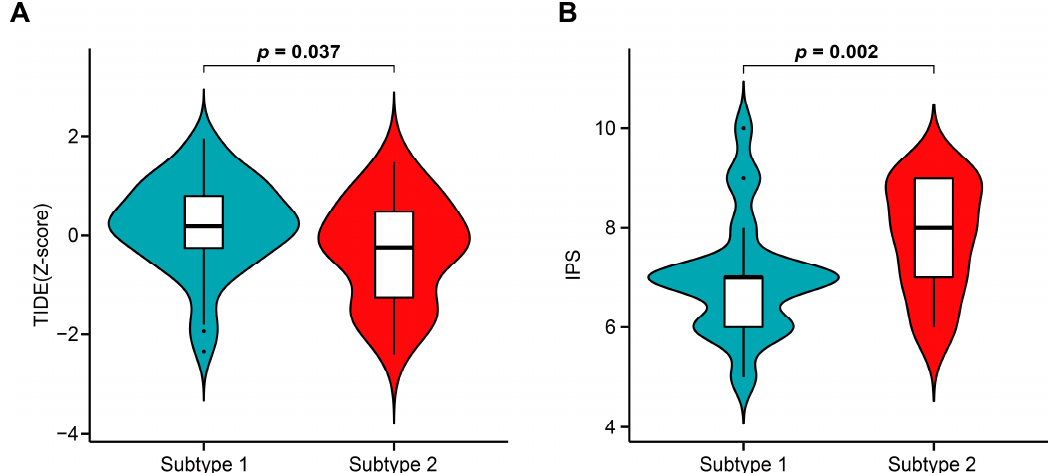
Figure 12. Association of TME-related subtypes with immunotherapy. ( A ) Comparisons of normalized TIDE scores between subtypes 1 and 2. ( B ) Comparison of IPS between subtypes 1 and 2.